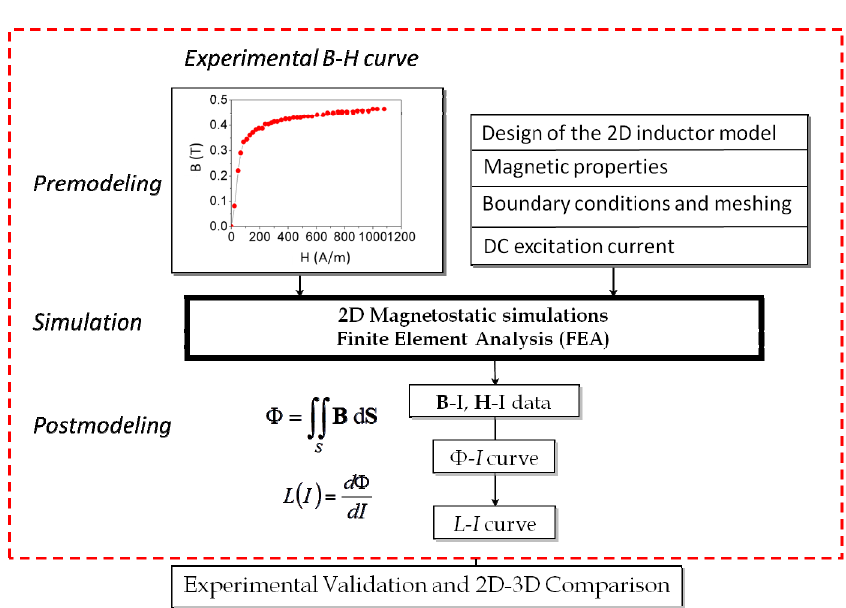
Figure 2. Simulation